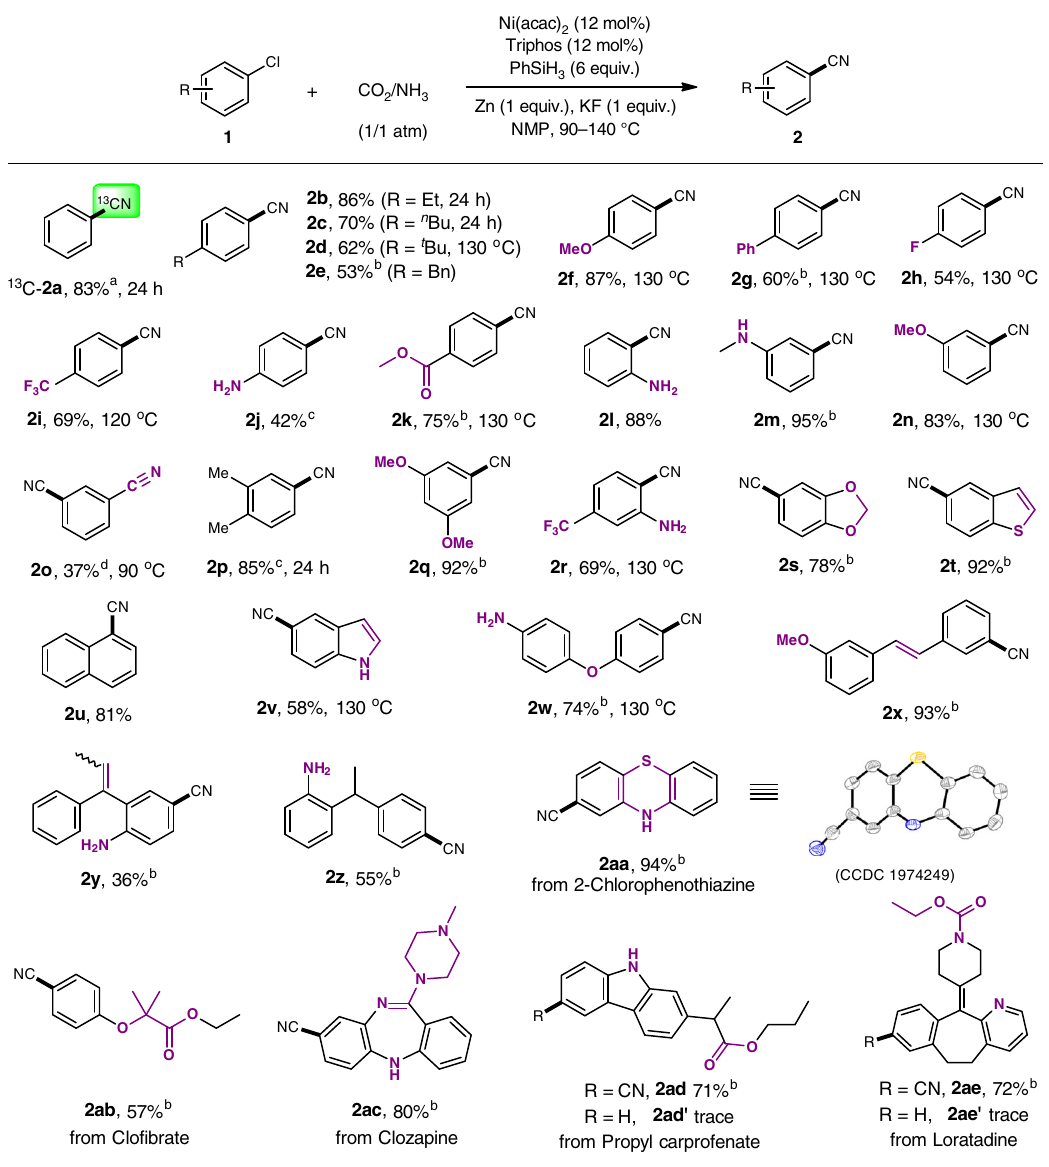
Fig. 3 Applicability study using CO 2 /NH 3 . Reaction conditions: 1 (0.125 mmol), CO 2 /NH 3 (1/1 atm), NMP (0.5 mL), 20 h, GC yield. a 13 CO 2 was used. b Isolated yields. c 15 mol% Ni(acac) d 10 mol% Ni(acac) 2 , 15 mol% Triphos. 2 , 10 mol% Triphos.